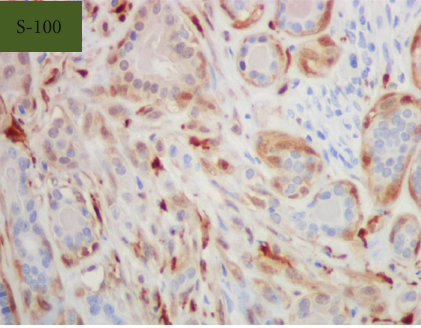
Figure 10: Ki-67 shows 2-3% proliferative activity (original magni- fication ×